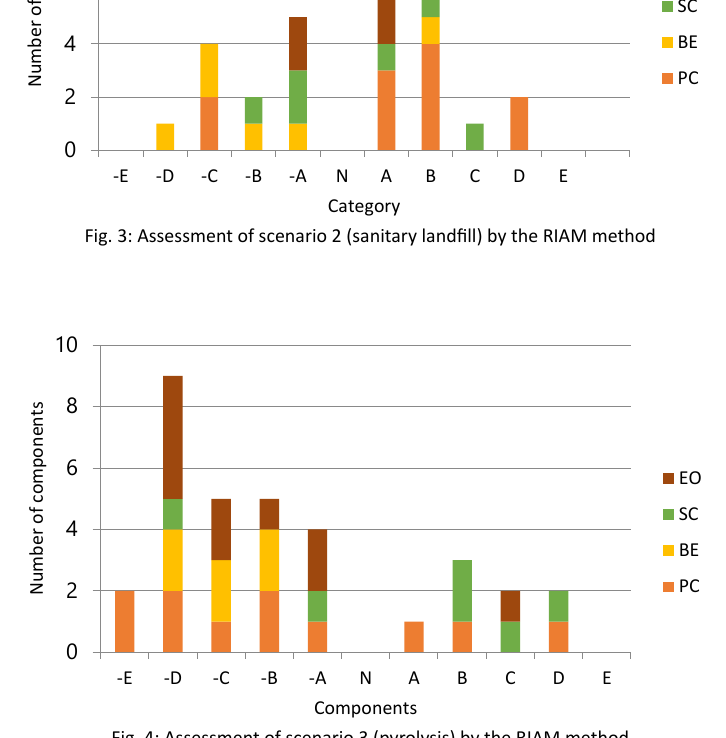
Fig. 4: Assessment of scenario 3 (pyrolysis) by the RIAM method